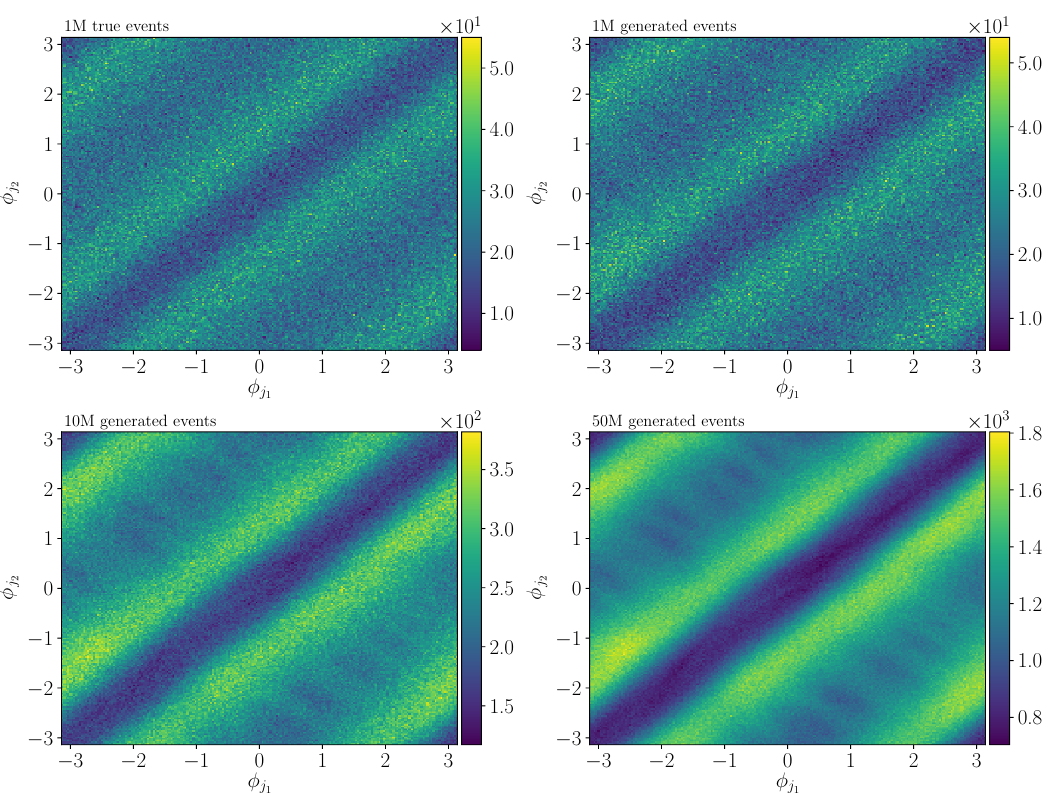
Figure 6: Correlation between φ for 1 million, 10 million, and 50 million GAN